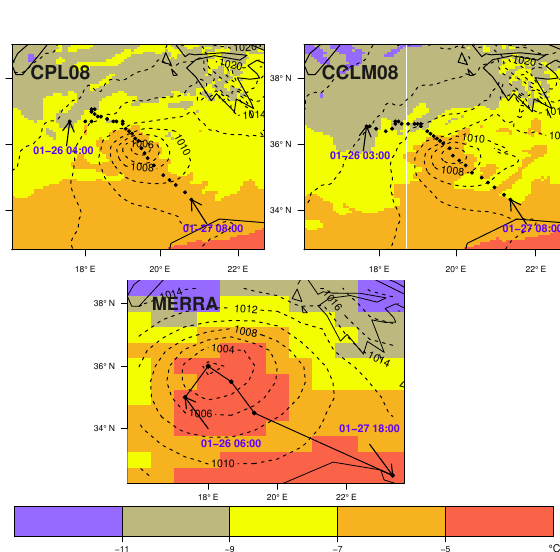
Figure 12. ME10; mean sea level pressure (hPa; dotted contours lines at 2hPa intervals) and temperature ( ◦ C: colored contours at 2 ◦ C intervals) at 700hPa in the coupled and atmosphere-only (0 . 08 ◦ ) simulations and the MERRA reanalysis data on 27 January 1998 at 00:00UTC. Black dots represent track of the medicane.